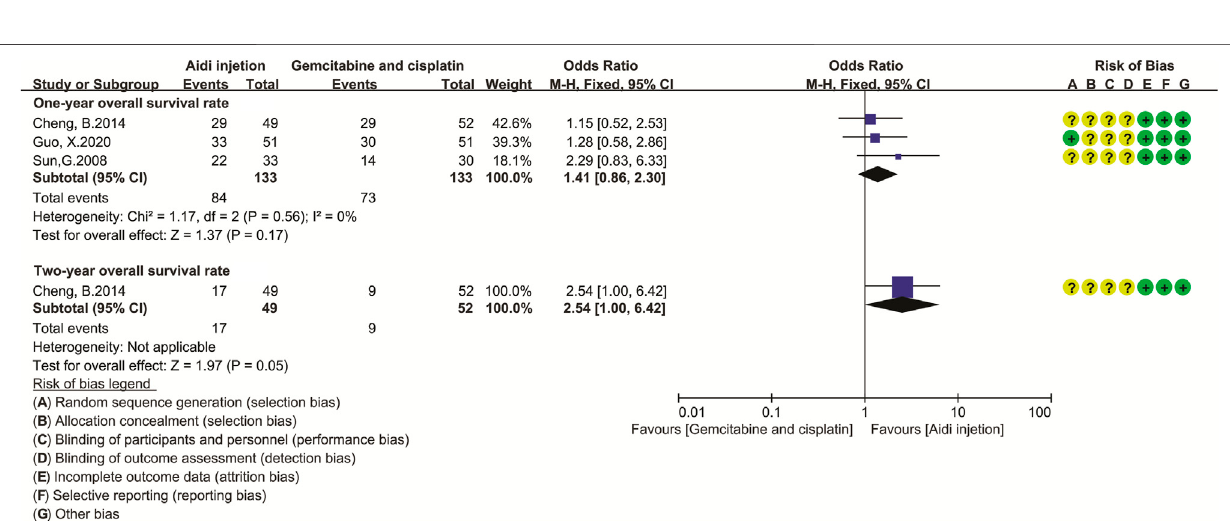
Frontiers in Pharmacology |